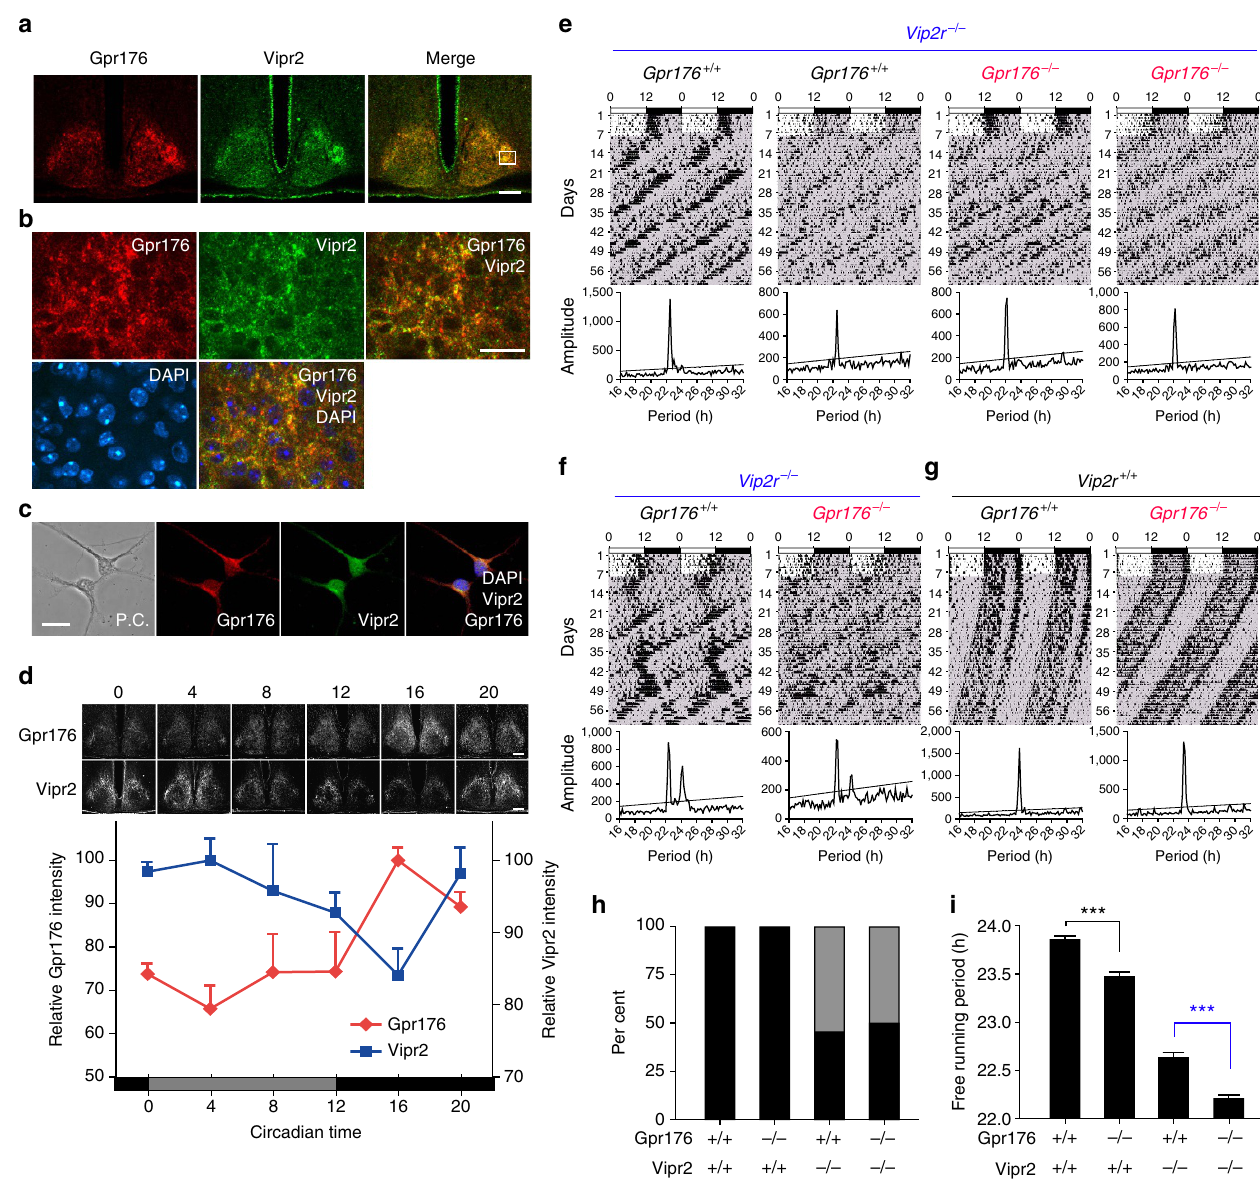
Figure 2 | Characterization of histological and genetic relationships between Gpr176 and Vipr2. ( a ) Double-label immunofluorescence of Gpr176 and Vipr2 in the mouse SCN. Coronal brain sections were immunolabeled with antibodies against Gpr176 (rabbit polyclonal) and Vipr2 (chicken polyclonal). Representative confocal pictures are shown, with a merged image of Gpr176 (red) and Vipr2 (green). Scale bar, 100 m m. ( b ) Enlargement of the boxed area in ( a ). Merge shows combined images for Gpr176 (red), Vipr2 (green), and DAPI-based nuclear staining (blue). Scale bar, 20 m m. ( c ) Immunofluorescence and phase contrast (P.C.) images of dispersed SCN neurons. Cells were immunolabelled for Gpr176 and Vipr2. Merge shows combined images of Gpr176 (red), Vipr2 (green), and DAPI (blue). Scale bar, 20 m m. ( d ) Antiphasic circadian expression profiles of Gpr176 and Vipr2 in the SCN. Values (mean ± s.e.m.) indicate relative immunoreactivities of Gpr176 and Vipr2 at 6 time points in DD ( n ¼ 6 brains for each data point). Representative images of the immunolabeled SCN sections are shown on the top. Scale bar, 200 m m. ( e – g ) Representative double-plotted actograms and w 2 periodograms of locomotor activity rhythms of mice carrying wild-type, Gpr176 (cid:2) / (cid:2) and Vipr2 (cid:2) / (cid:2) alleles. Vipr2 (cid:2) / (cid:2) mice exhibit a single ( e ) or multiple ( f ) circadian periods in DD, while all wild-type and Gpr176 (cid:2) / (cid:2) mice had a single, stable circadian period ( g ). Diagonal line on periodogram shows significance at P o 0.001. See also Supplementary Fig. 6. ( h ) Percentage of mice expressing a single dominant circadian period (black) or multiple circadian periods (grey). n ¼ 8 (cid:2) 12 for each genotype. ( i ) Group data showing individual and combined effects of Gpr176 (cid:2) / (cid:2) and Vipr2 (cid:2) / (cid:2) on circadian period of locomotor activity rhythms. Values (mean ± s.e.m.) indicate free-running periods of mice with a single dominant period in DD ( n ¼ 5 (cid:2) 8). *** P o 0.001, one-way ANOVA with Bonferroni post hoc test.